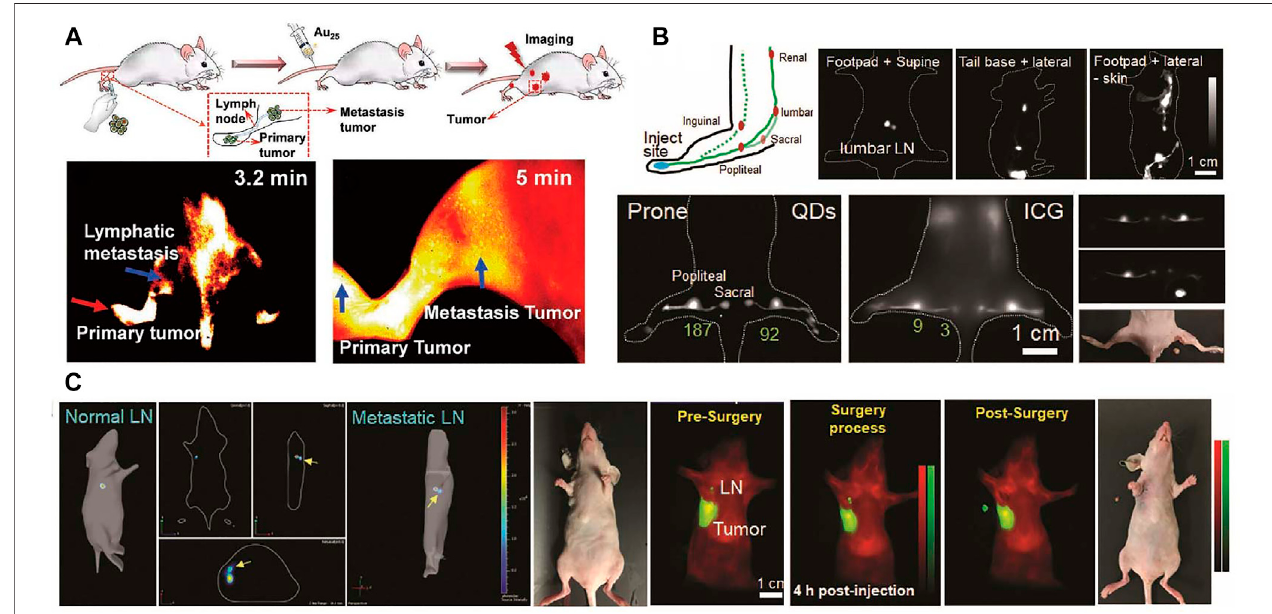
FIGURE 7 | Lymphatic imaging. (A) Schematic graphic of tumor metastasis, dynamic primary tumor and lymphatic metastasis imaging (Liu et al., 2019). Reproduced with permission from Zhang et al. (2019). (B) Schematic illustration of lymphatic system in the hindlimb, lumbar, renal lymph nodes and the advantages of QDs in popliteal and sacral lymph nodes imaging compared with ICG; NIR imaging guided surgery of popliteal lymph node. (C) The dual NIR imaging guided sentinel lymph node surgery in orthotopic 4T1 breast cancer model (Tian et al., 2020). Reproduced with permission from Chen et al.